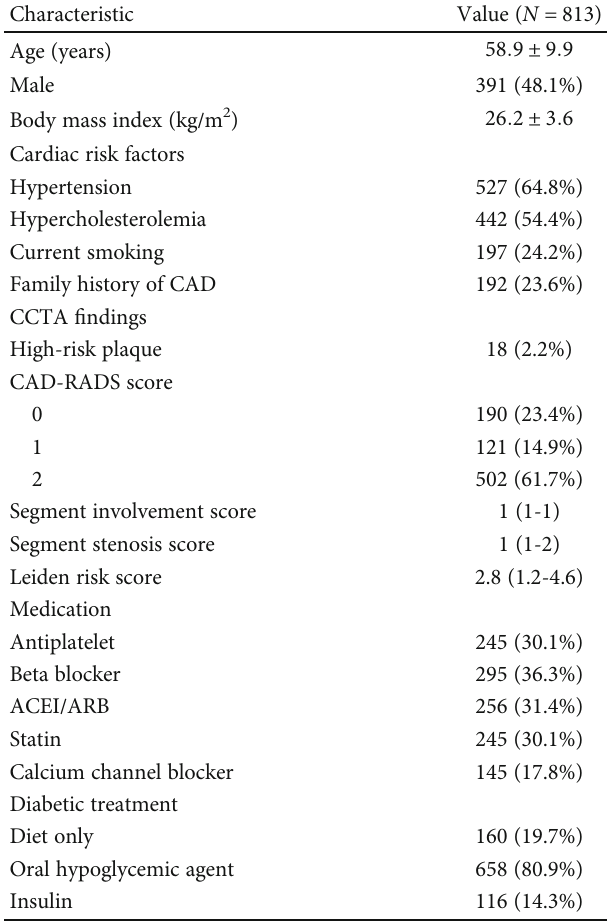
Table 1: Baseline